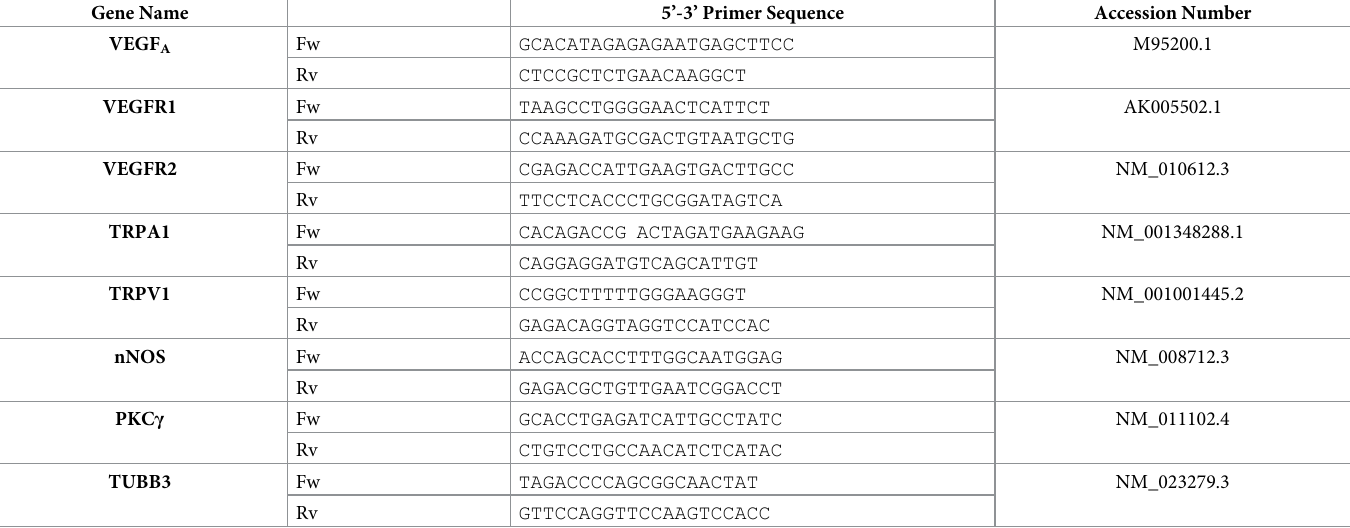
Table 1. Primer sequences used in qPCR experiments.